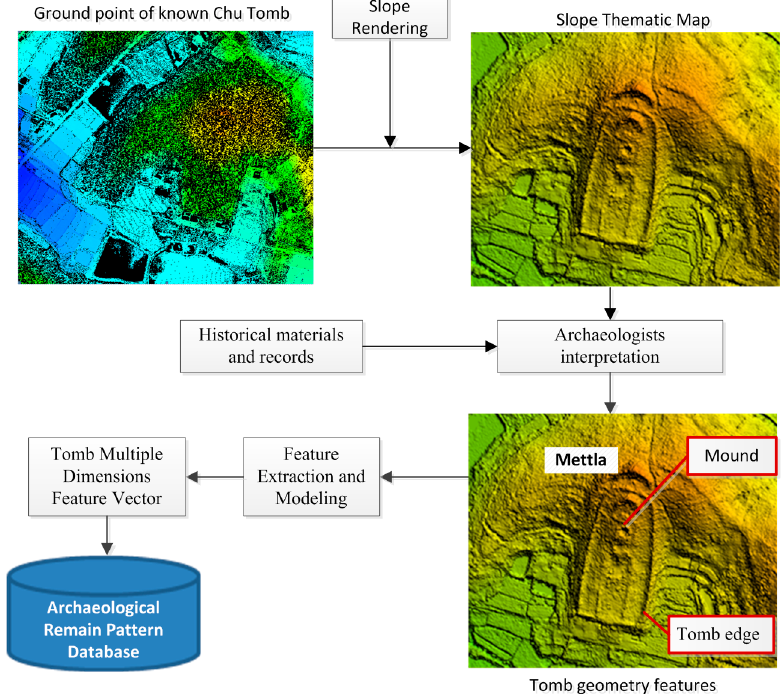
Figure 7. Pattern analysis method used to build a database of the patterns of archaeological remains.